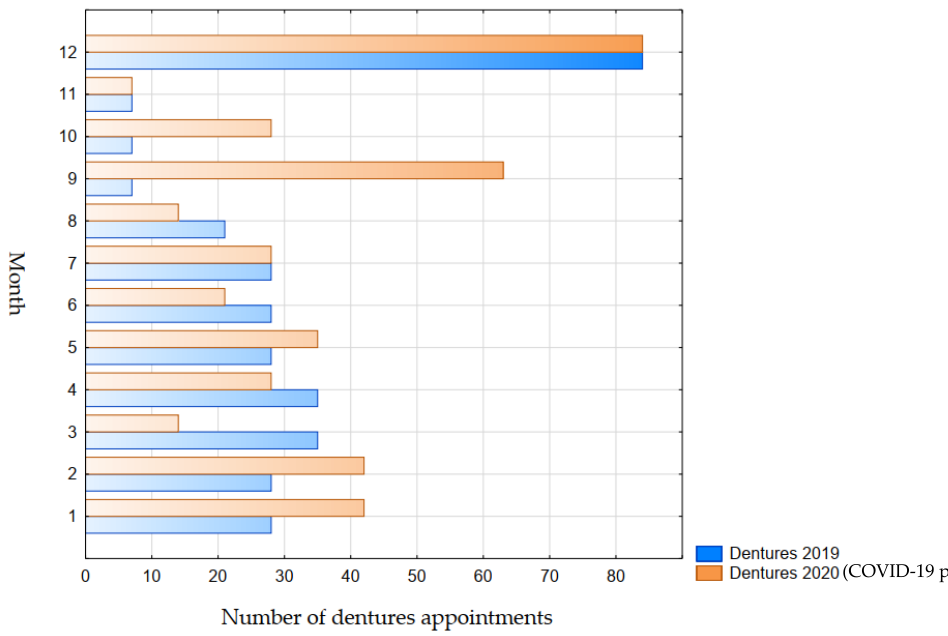
Figure 5. Change in the number of dentures appointments during the pandemic period from the prepandemic period.